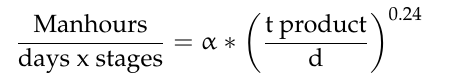
Table 1. Ultimate and proximate and chemical analysis of rice husk (RH) [6].